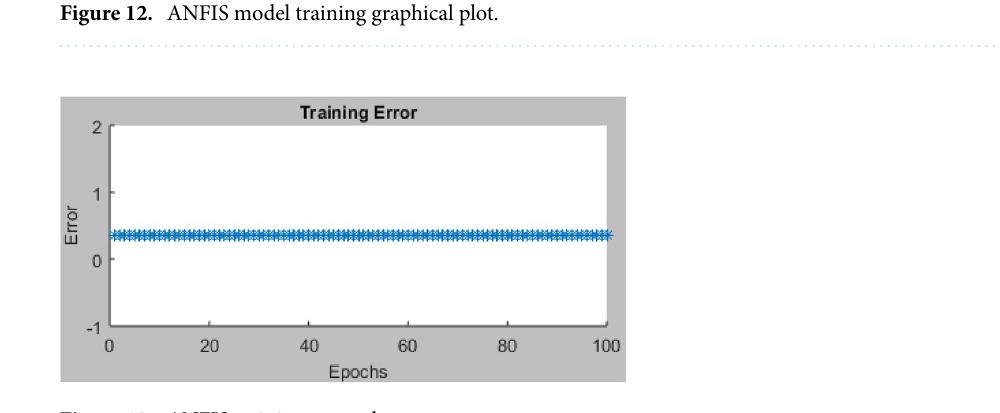
Figure 13. ANFIS training error plot.